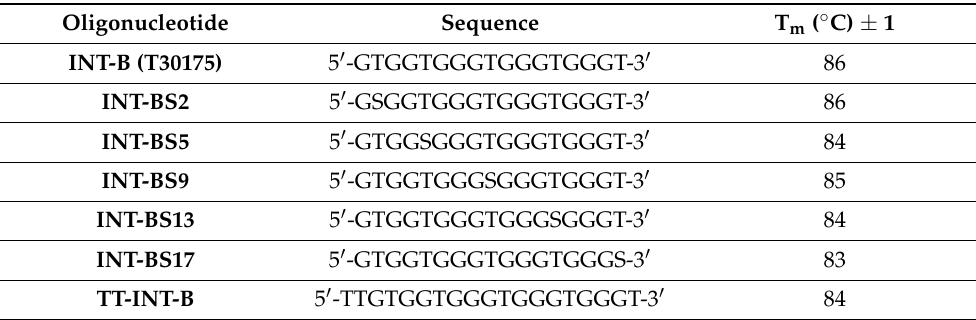
Figure 1. Schematic representation of the parallel-stranded G-quadruplex dimer structure of T30175 ( INT-B ) and the chemical structure of the abasic site mimic (S), introduced in positions 2, 5, 9, 13, and 17. All guanosines adopt anti glycosidic conformations (in light blue). The thymidines are represented as black circles and are labeled in red. Table 1. Sequence and melting temperature (Tm) of the investigated ODNs. S indicates an abasic site